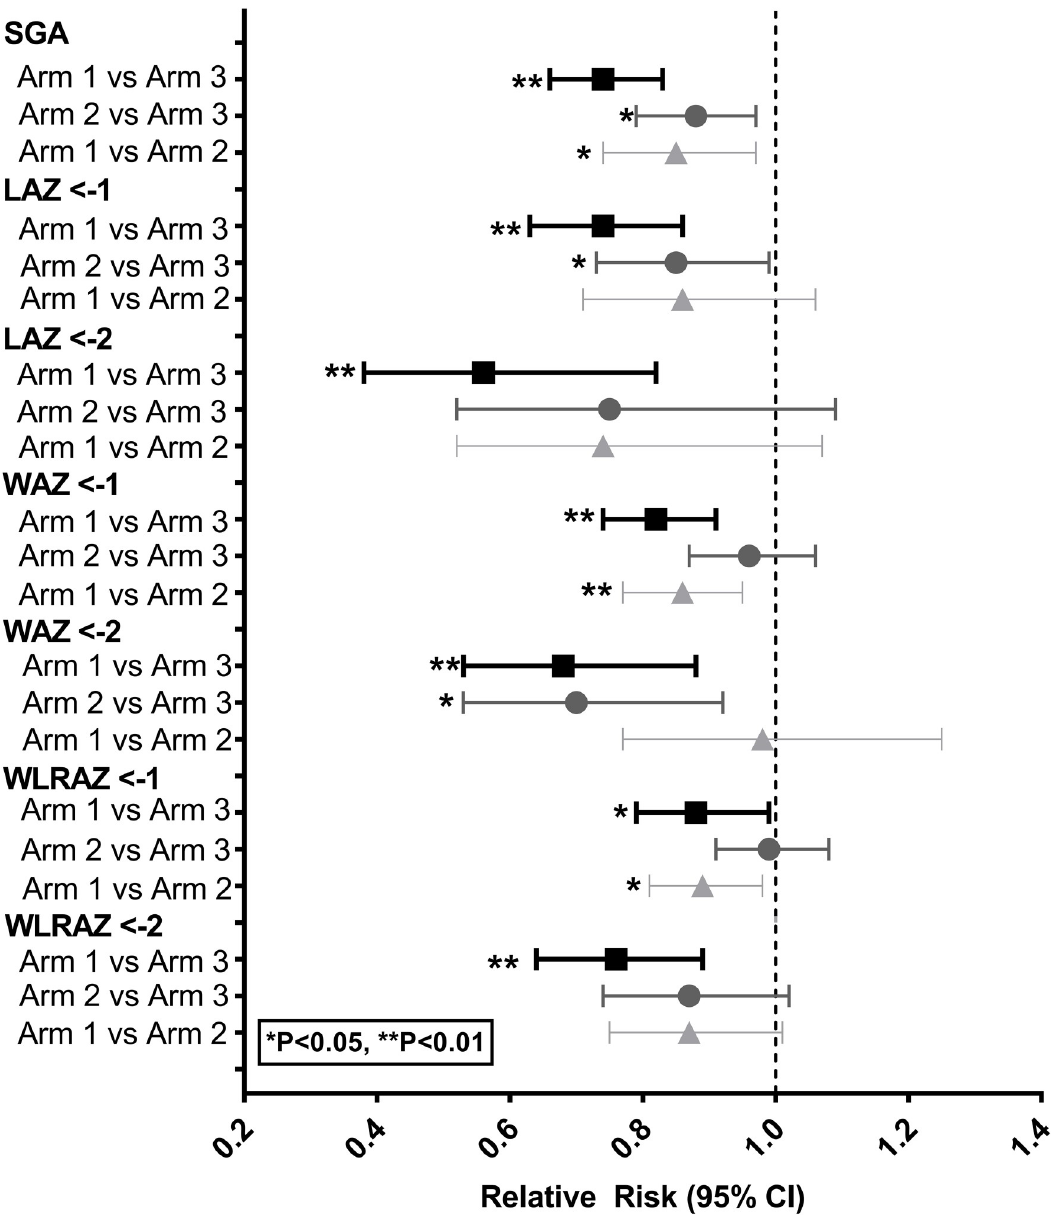
Fig 3. Women First Preconception Maternal Nutrition Trial: Relative risks (95% confidence intervals) for binary newborn anthropometric outcomes in South Asian region. LAZ, length-for-age Z-score; SGA, small-for-gestational age; WAZ, weight-for- age Z-score; WLRAZ, weight to length ratio-for-age